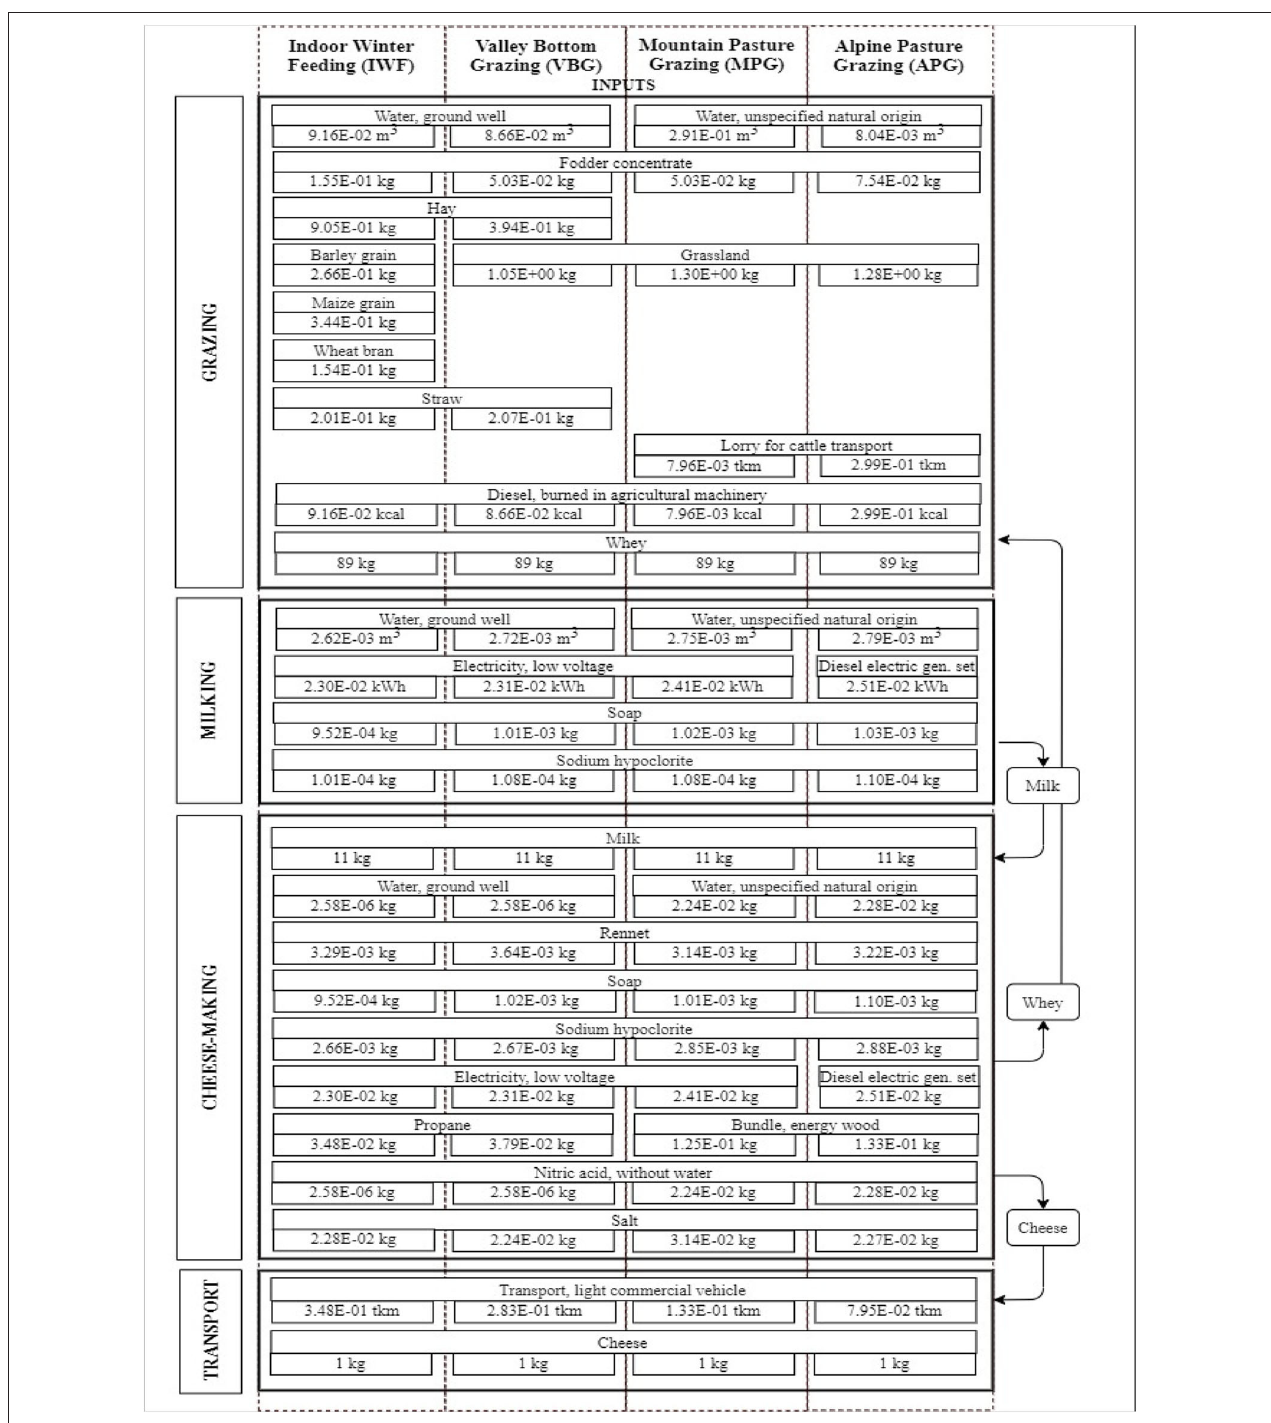
FIGURE 1 | Inventory input from cradle-to-retail and system boundaries. Dotted lines represent the scenarios and black squares the phases. of concentrate. In the LCA inventory, only purchased foodstuffs Some inputs are common to all scenarios, whereas other have been included, since the impact of feed production in farms inputs are specific. More precisely, in the APG and MPG had already been taken into account (land occupation and diesel scenarios, the water used in the grazing phase is spring water, consumption for farming), in accordance with Laca et al. (39). while in the VBG and IWF scenarios it is supplied by a